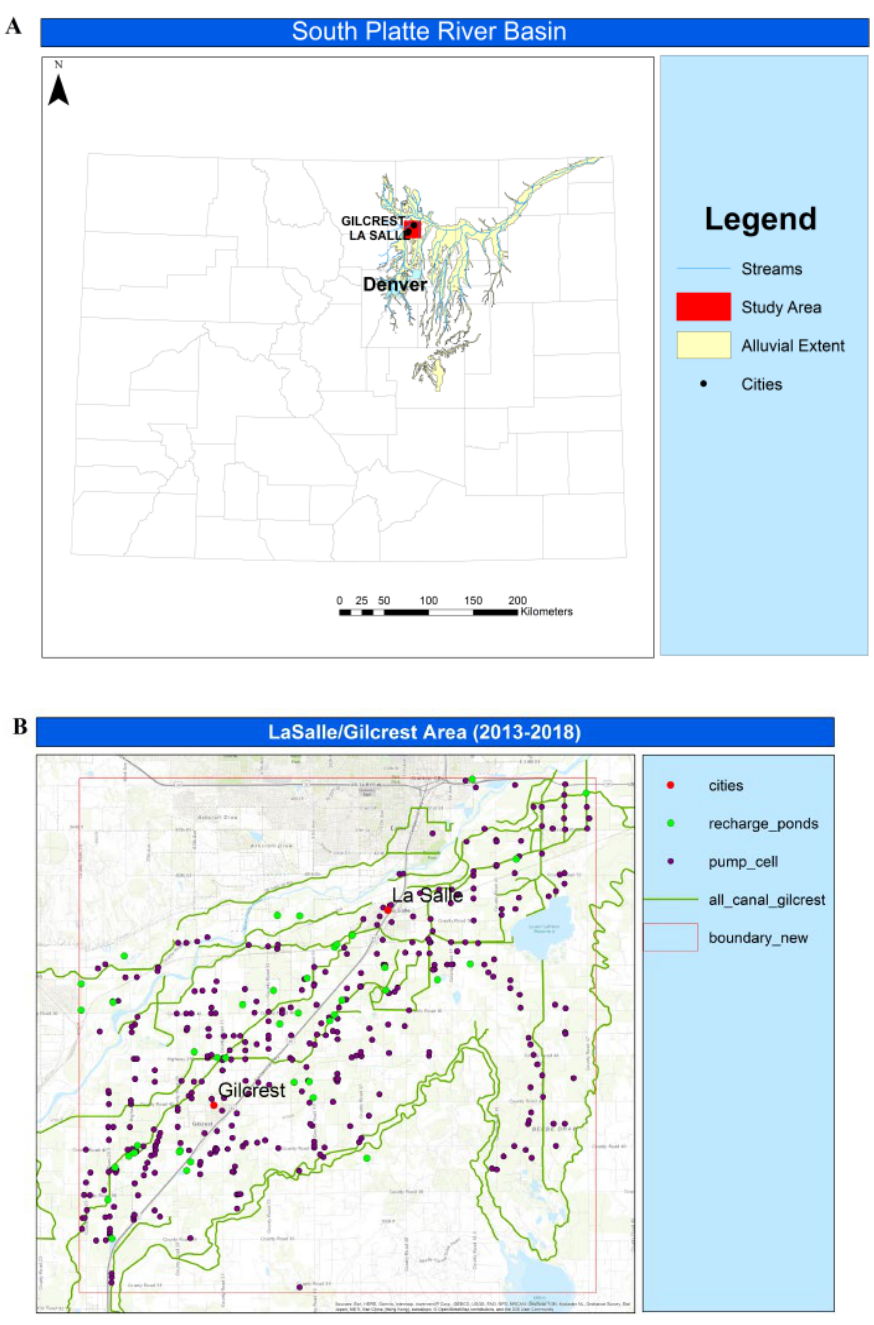
Figure 1. Figure ( A ) shows the South Platte River basin in Colorado. The red area is the study area where the city of Gilcrest and La Salle is located. Figure ( B ) shows the location of Gilcrest and LaSalle, the South Platte River, the four irrigation canals, recharge ponds, and the location of the 340 pumping wells (green